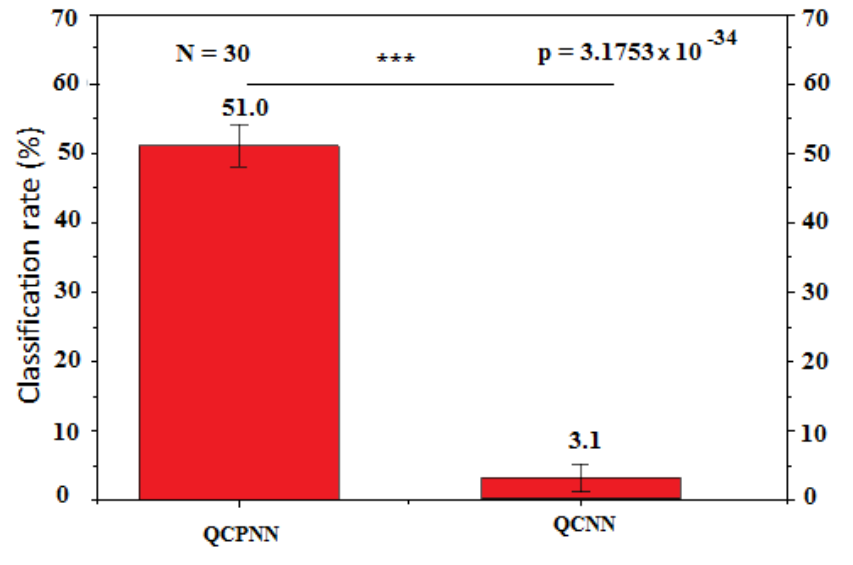
Figure 5. Comparison of the classification rates of the proposed model QCPNN and the QCNN model [21], for classifying the state of RCP in a risky NPP. Red bars indicate mean values averaged over N = 30 runs, error bars indicate the corresponding standard deviations. The difference is highly significant ( p = 3.1753 × 10 − 34 < 0.001). For both models the number of neurons was set to